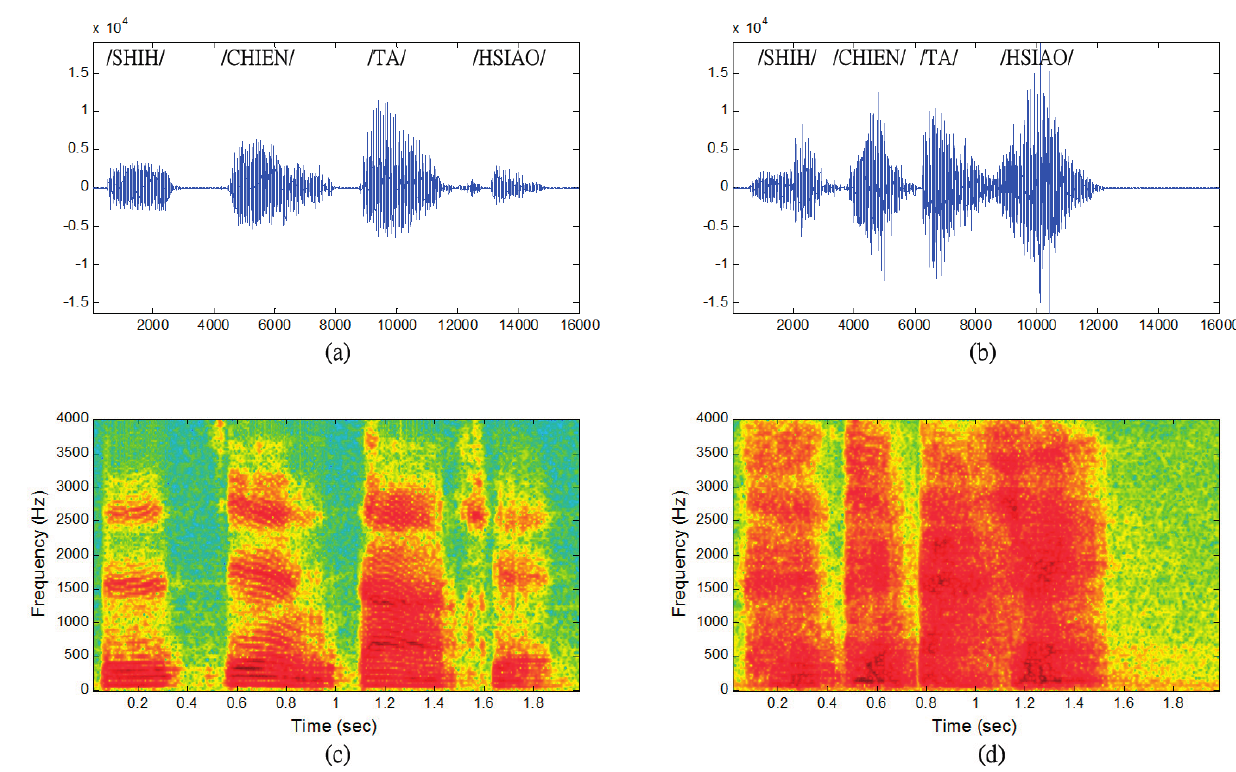
Figure 2. The input speech signals and the corresponding spectrograms. Speech uttered in Mandarin sentence “SHIH-CHIEN-TA-HSIAO.” ( a ) “Neutral” speech. ( b ) “Anger” speech. ( c ) Spectrogram of “Neutral” speech. ( d ) Spectrogram of “Anger”